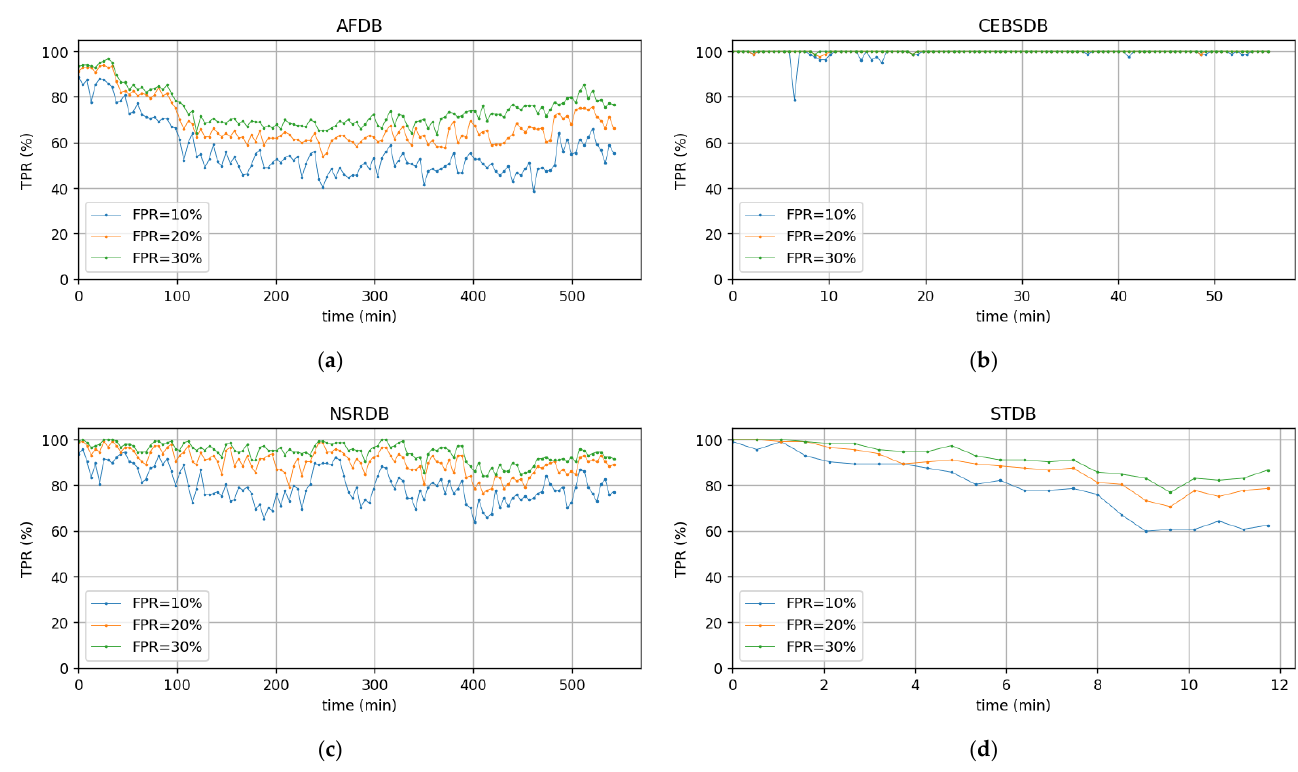
Figure A7. Area under ROC curve of individual verification is plotted against time separation for: